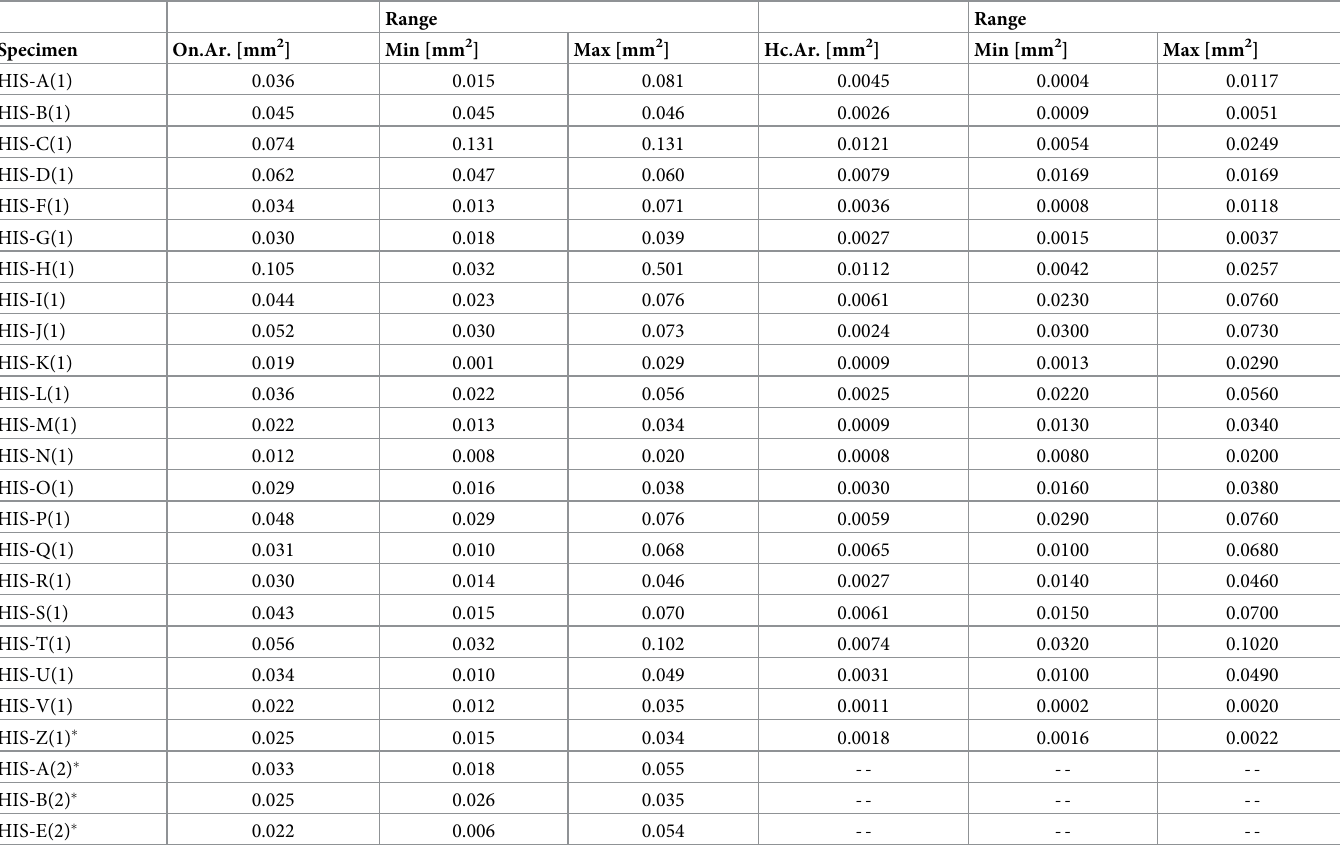
Table 4. The histomorphometric analysis of human and faunal specimens from the Tomb of Nestor’s